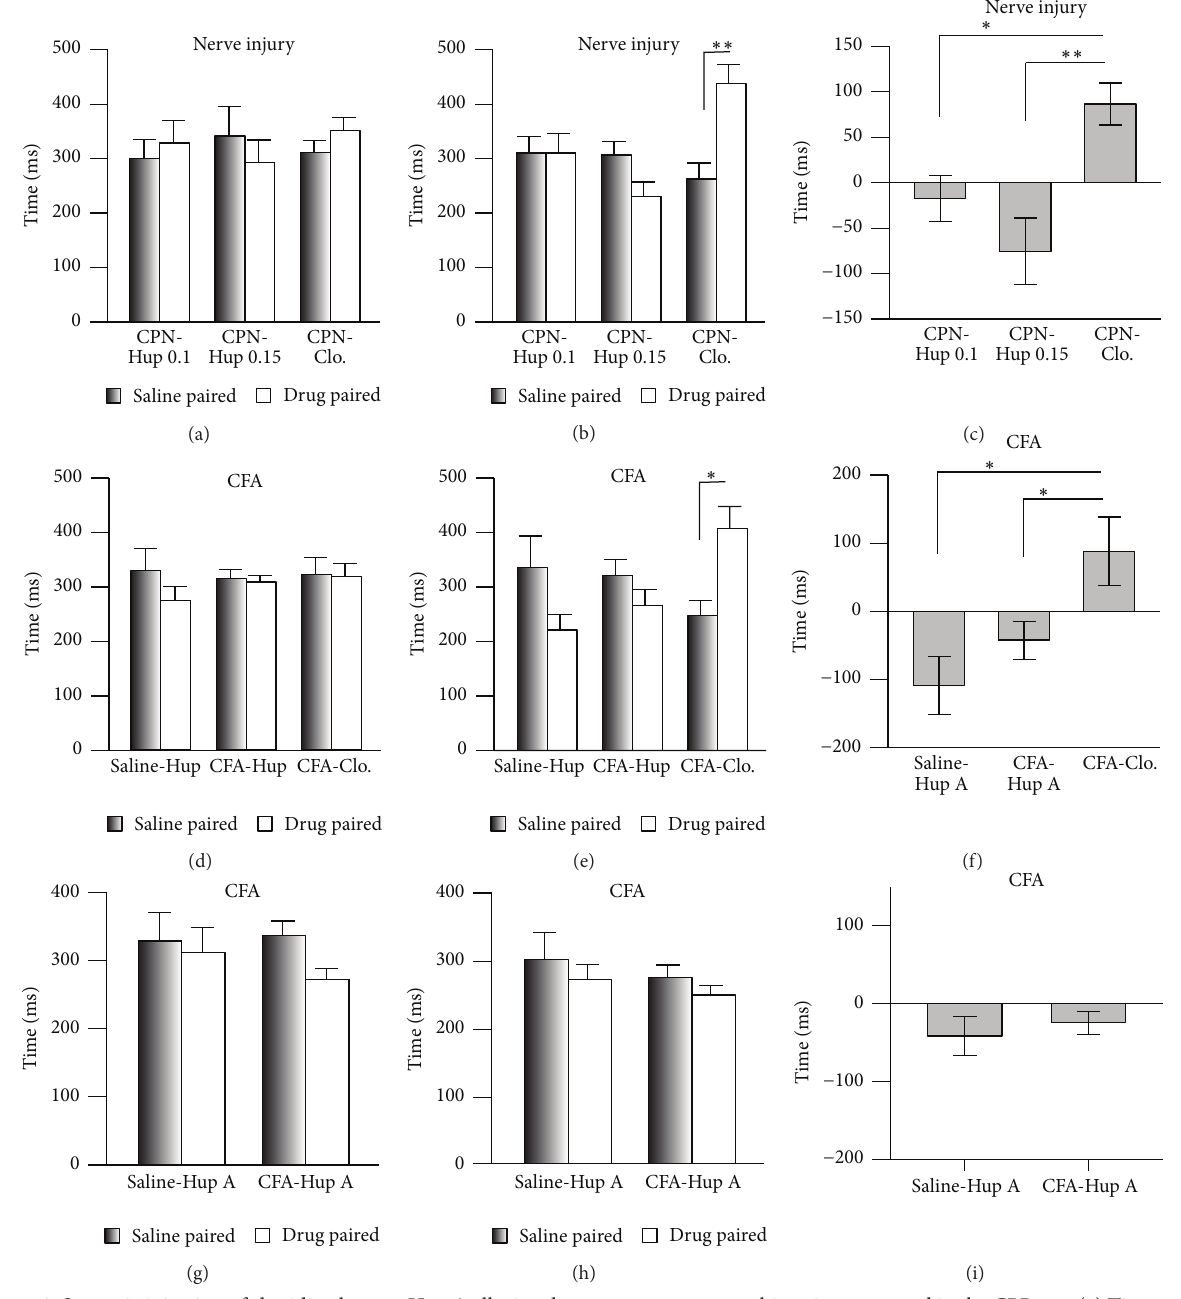
Figure 2: Systemic injection of clonidine but not Hup A alleviated spontaneous neuropathic pain as assessed in the CPP test. (a) Times spent in the chambers during the preconditioning period (two-way RM ANOVA, groups: 𝐹 2;33 = 1.30 , 𝑃 > 0.05 ; saline versus drug: 𝐹 1;33 = 0.03 , 𝑃 > 0.05 , 𝑛 = 6 for Hup 0.1, clonidine group, 𝑛 = 5 for Hup 0.15). (b) Clonidine but not Hup A (0.1mg/kg and 0.15 mg/kg) induced preference for the drug-paired chamber (two-way RM ANOVA, groups: 𝐹 2;33 = 11.79 , 𝑃 < 0.01 ; saline versus drug: 𝐹 1;33 = 0.98 , 𝑃 > 0.05 , 𝑛 = 6 for